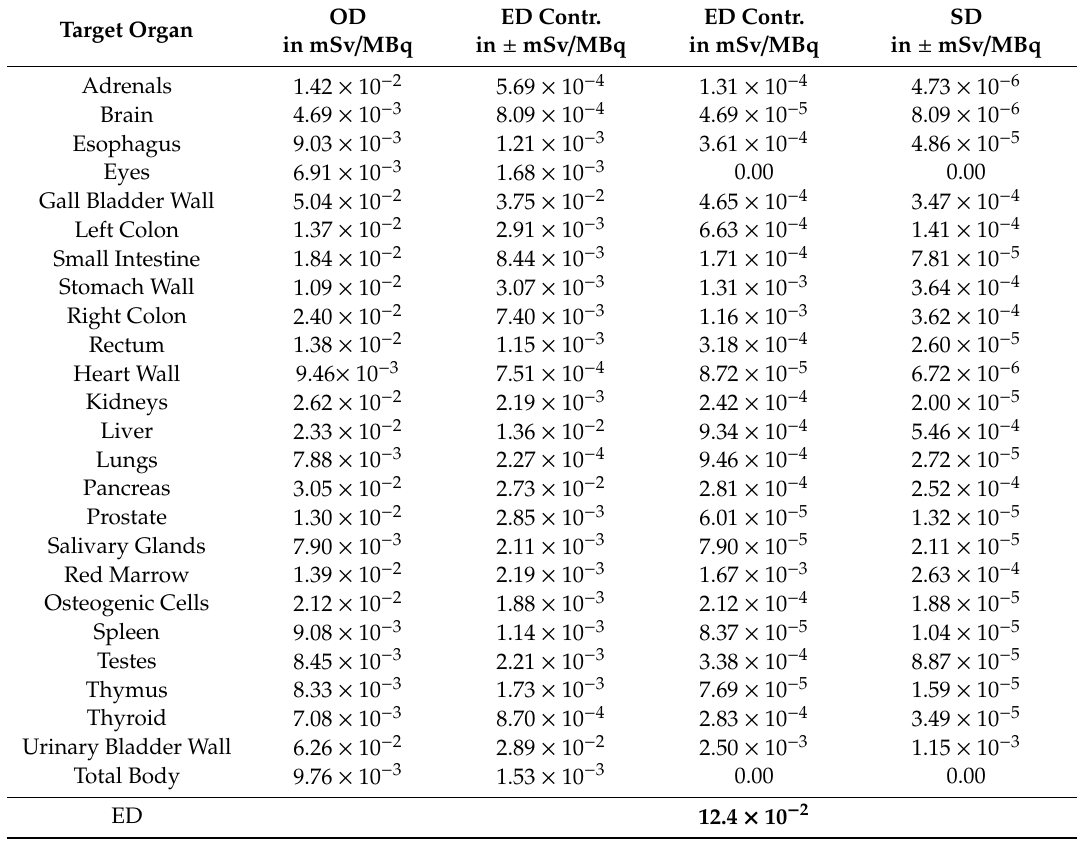
Table 1. Complete results of the dose assessment of the three investigated piglets using OLINDA 2.1 (mean value ± standard deviation